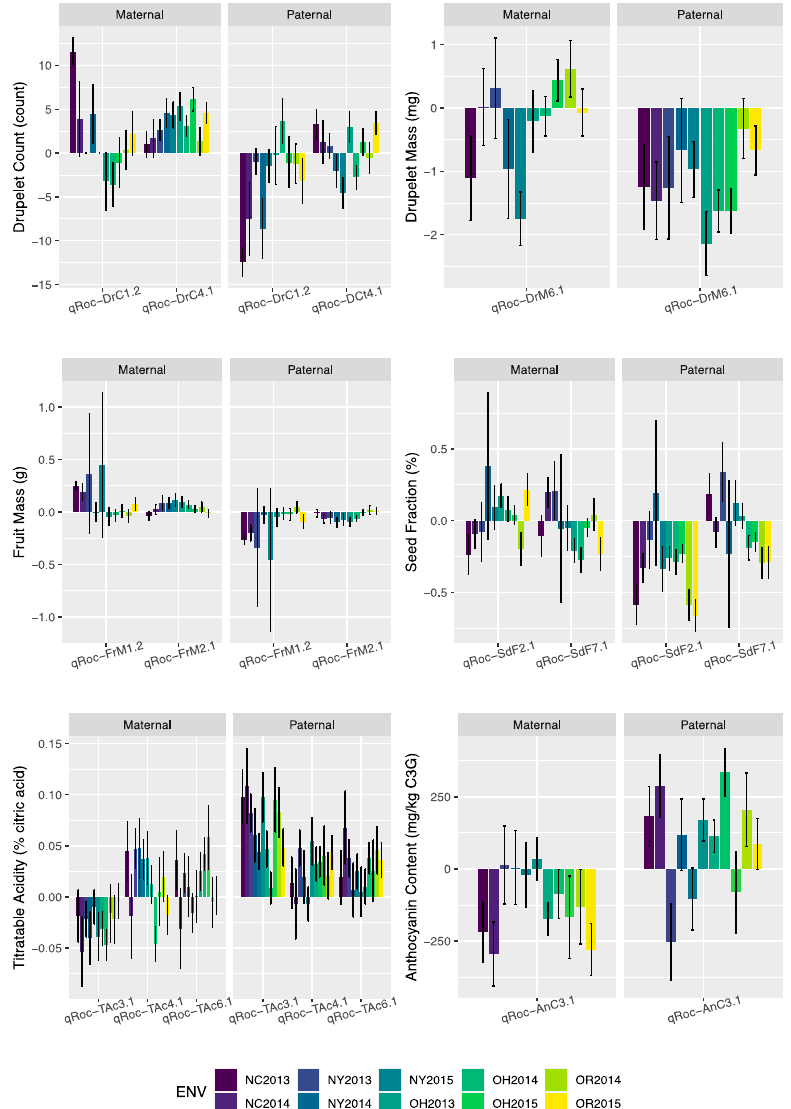
Figure 5. Additive effect size of unstable fruit morphology and fruit chemistry QTL identified by multiple-environment analysis.